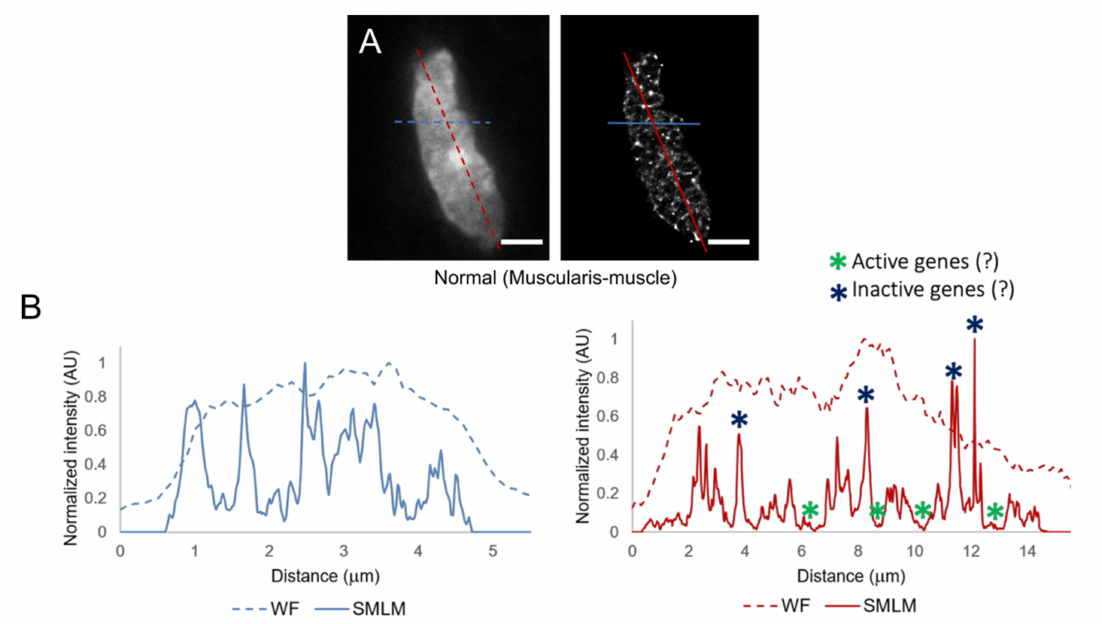
Figure 4. Chromatin density profiles of a normal colorectal muscle nucleus. ( A ) Widefield image and its super-resolved (SMLM) reconstruction. ( B ) Comparison of intensity profiles taken from the widefield image (dotted lines) and the SMLM reconstruction (solid lines). Location of active/inactive genes is hypothesised. Scale bars: 3 µ